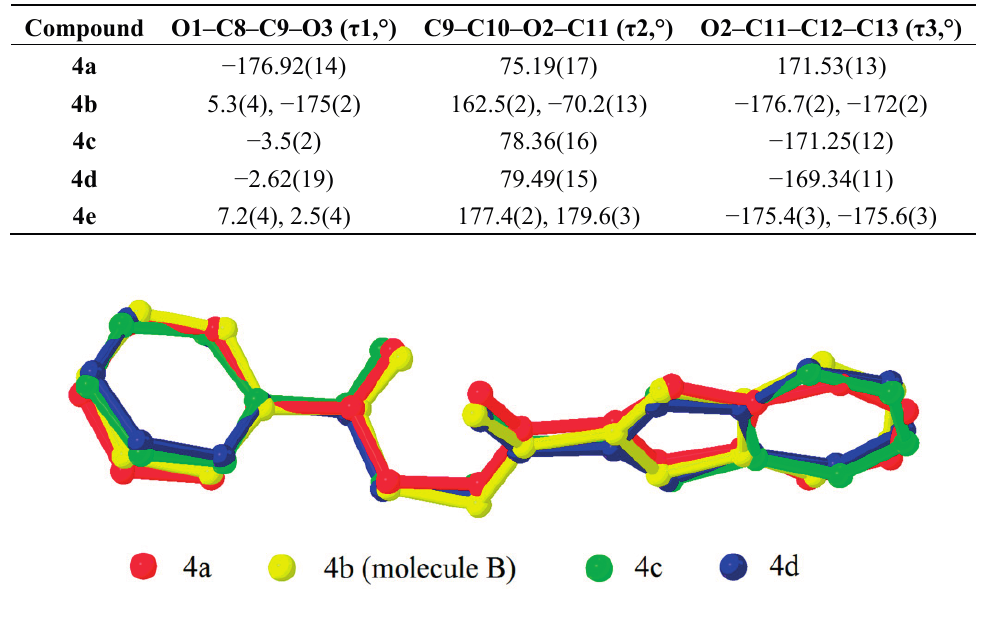
Table 2 . Torsion angles τ 1, τ 2 and τ 3 for 4 ( a – e ).